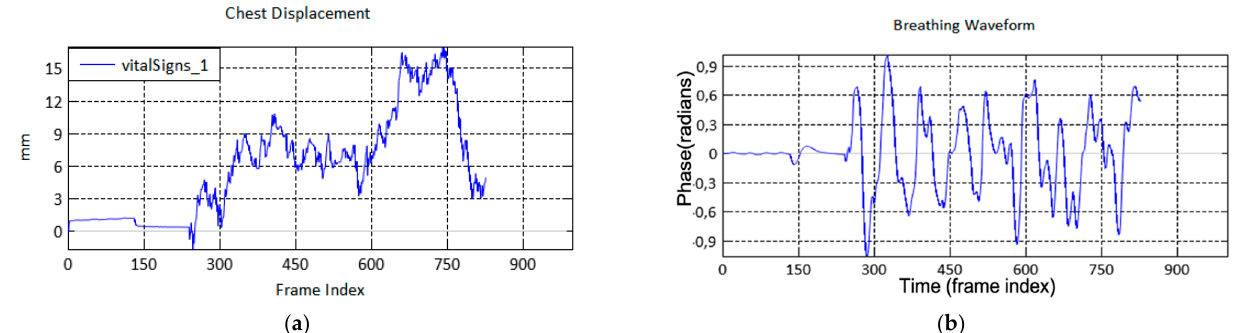
Figure 6. ( a ) Unwrapped phase after the phase difference and noise removal, labelled as the chest displacement; ( b ) the output of IIR BPF is the breathing waveform.